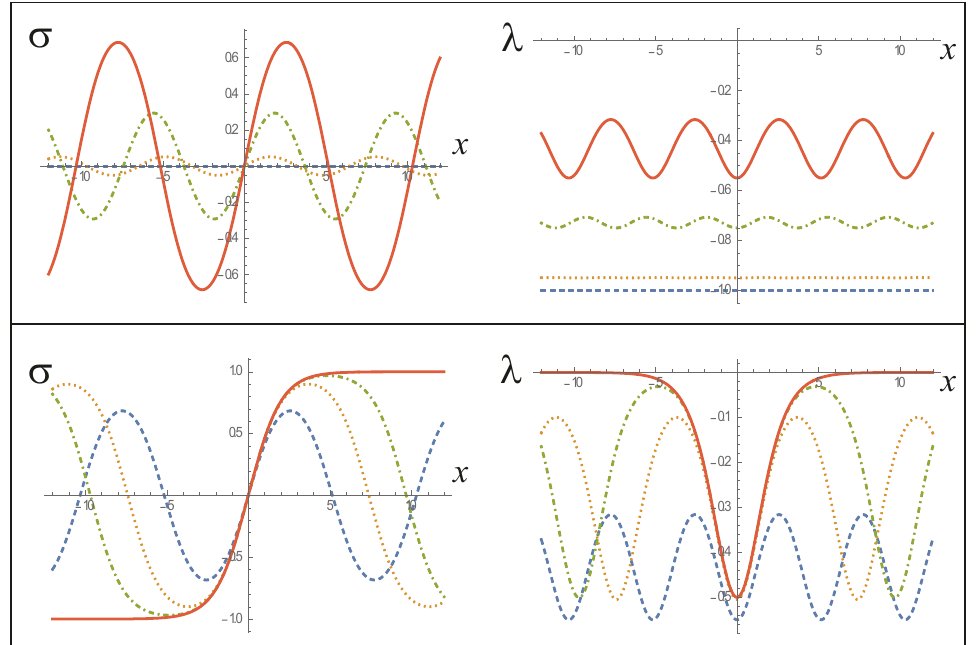
Figure 3 . The localized con(cid:12)ning soliton lattice con(cid:12)guration with di(cid:11)erent (cid:23) . The upper (cid:12)gures correspond to (cid:23) = 0 (dashed line), (cid:23) = 0 : 1 (dotted line), (cid:23) = 0 : 5 (dot-dashed line), and (cid:23) = 0 : 9 (solid line). The lower (cid:12)gures correspond to (cid:23) = 0 : 9 (dashed line), (cid:23) = 0 : 99 (dotted line), (cid:23) = 0 : 999 (dot-dashed line), and (cid:23) = 1 (solid line). Here we set, m = 1 and normalize the peak of (cid:27) to be